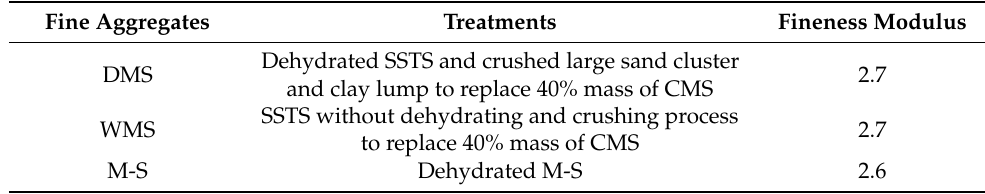
Table 4. Three types of fine aggregates used in concrete preparation.